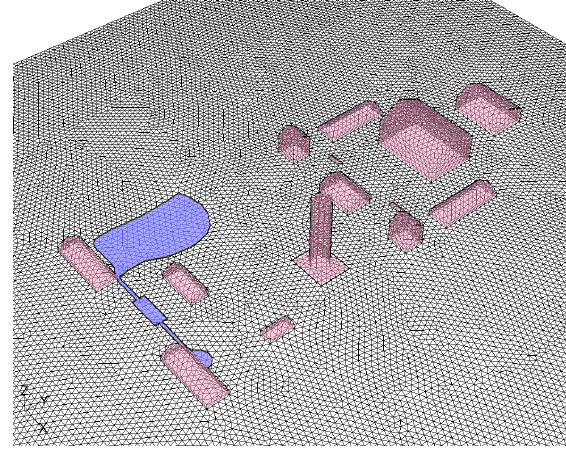
Figure 7. Unstructured grid.